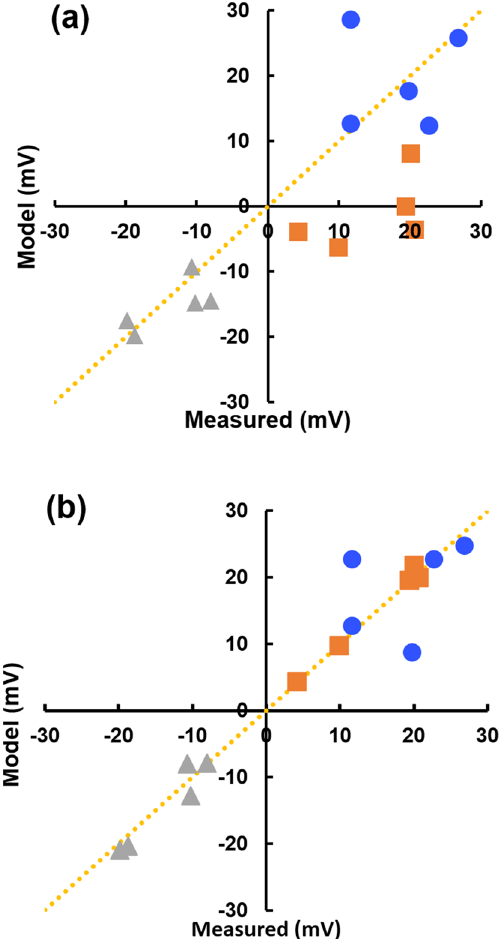
Figure 4. Scatter plots showing the correlation between measured values of membrane potential, and two models of membrane potential: ( a ) Eq. (12); and ( b ) Eq. (13) for measurements derived from normal (triangles; 1.8 S m −1 ) and lower (squares; 0.18 S m −1 and circles; 0.018 S m −1 ) conductivities. Dotted line is that of